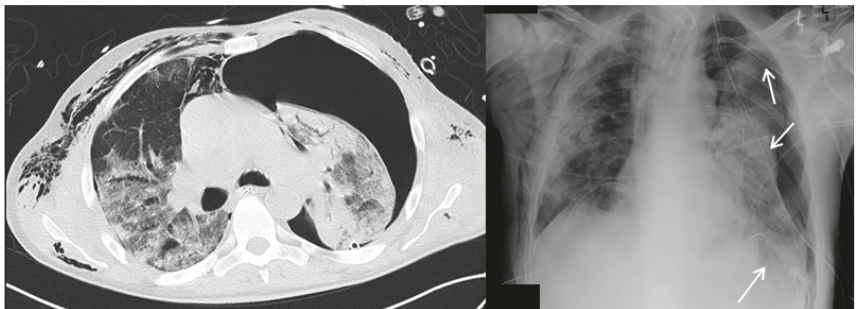
Figure 1: CT-scan (left image) and chest X-ray (right image) on day 16 before endobronchial valve placement: large pneumothorax despite three chest drainages on the left (white